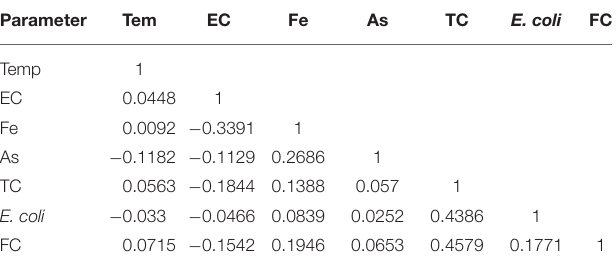
TABLE 3 | Pearson correlations among different water quality parameters at PoS (Obs 377).